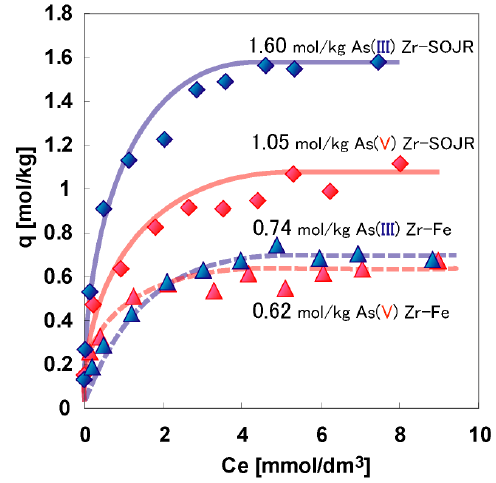
Figure 25. Isotherms for the adsorption of As(III) and As(V) by Zr(IV)-loaded SOJR and by zirconium ferrite (Zr-Fe) at 30 °C . Adsorbent mass = 25 mg, test solution volume = 15 mL, adsorption pH for As(V) = pH 3, adsorption pH for As(III) = pH 10 [16]. (With permission for reuse from Indonesian Chemical Society).